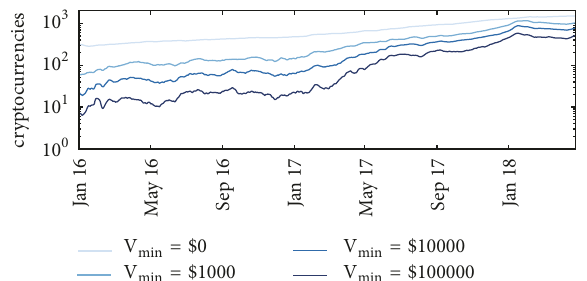
Figure 1: Number of cryptocurrencies. The cryptocurrencies with volume higher than 𝑉 𝑚𝑖𝑛 as a function of time, for different values of 𝑉 𝑚𝑖𝑛 . For visualization purposes, curves are averaged over a rolling window of 10